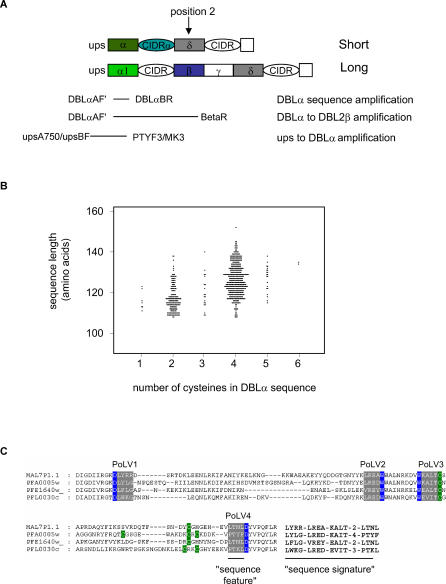
Organizational Features of var Genes(A) var gene organization. The var genes are complex, multi-domain structures composed of variable numbers of DBL domains (rectangles) of different sequence classes (DBLα, -β, -γ, -δ, and -ɛ plus several heterogeneous DBLX) and cysteine-rich interdomain regions (CIDR, ovals), also of different classes (CIDRα, -β, and -γ). Despite this complexity, the majority of var genes in the 3D7 genome can be described according to (1) whether they belong to a small set of long genes that encode PfEMP1 molecules with 6–9 domains or to a much larger set of short genes that encode short PfEMP1 molecules with only four domains; (2) their telomeric or internal position within the chromosome; (3) their direction of transcription, either towards the telomere or towards the centromere; (4) the sequence of their second most N-terminal DBL domain (DBL2), either DBL2β, DBL2δ, or DBL2γ; and (5) their association with one of five upstream (ups) regulatory sequences, upsA, upsB, upsC, upsD, or upsE [1,25,26]. The genes do not fall randomly within these categories. For example, of the long var genes, most have a DBL2β and are associated with upsA, whereas most short genes have a DBL2δ. Of the telomeric genes, most of those that are transcribed towards the telomere are associated with upsA, whereas all those transcribed towards the centromere are associated with upsB [28,33]. This apparent genetic structuring is associated with functional specialization. A subset of CIDR regions (CIDRα) situated immediately 3′ of DBLα bind to CD36 when expressed as recombinant peptides (teal shaded oval). These regions are generally replaced by non-CD36-binding CIDR regions in long var genes [27]. In 3D7, long var genes tend to be associated with a distinct subset of DBLα domains called “DBLα1” [27]. This observation is potentially very useful since DBLα and DBLα1 sequences can be PCR amplified from nearly all var genes using a universal set of degenerate primers [29]. Examples of long and short var genes found in the 3D7 genome are shown. A white square is used to represent the conserved exon 2 at the C-terminal end. Short genes are relatively conserved in domain structure. Long genes have variable organization. Two forms of PCR product were cloned and sequenced. DBLα-specific primers (DBLαAF′ and DBLαBR) were used to amplify DBLα sequences from cDNA and genomic DNA from each parasite isolate. DBLαAF′ and BetaR primers were used to amplify genomic DNA from isolates 4111 and 4161. Four further primers were used in different combinations to amplify between DBLα and ups.(B) Distinct DBLα sequences categorized according to the number of cysteine residues in the sequence. The number of cysteines present in each distinct DBLα sequence is plotted against the length of the sequence.(C) The location of sequence features. PoLVs are in gray. The conserved amino acids to which they are anchored are in blue. Cysteine residues are highlighted in green. The derived “sequence signature” for each clone is indicated.